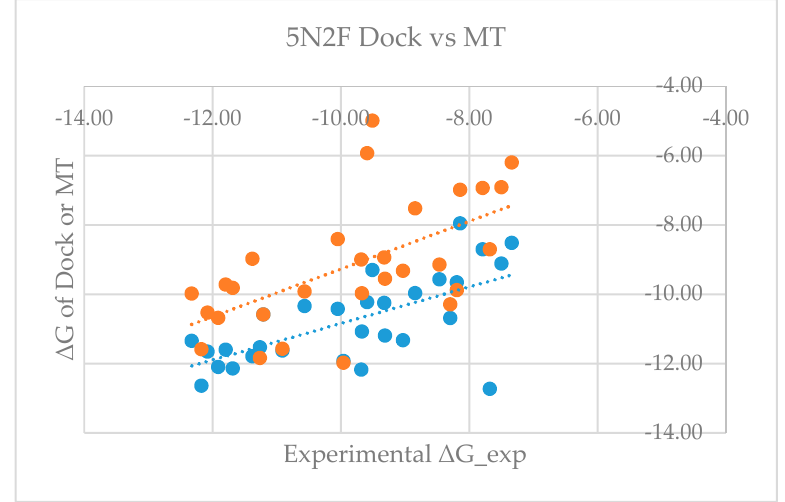
Figure 4. Plot of experimental Δ G versus glide dock-based and MT-based Δ G for the 5N2F model (blue: 5N2F_Dock, orange: 5N2F_MT).